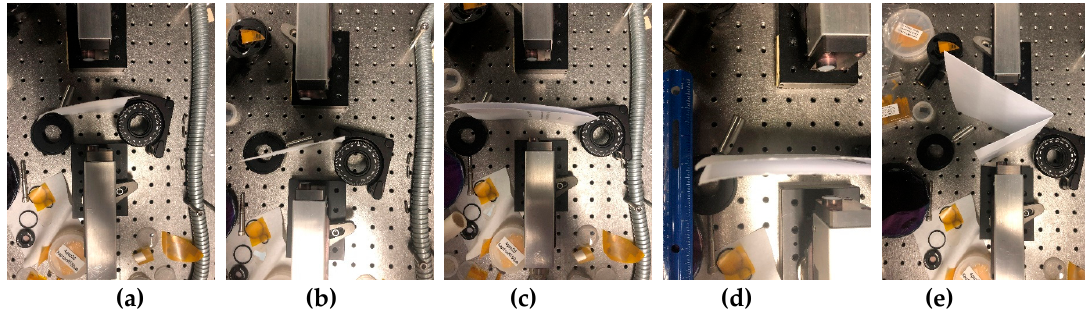
Figure 17 . Location of the paper sheets in the THz spectrometer (a – e). One (a,b) , two (c,d) and four sheets (e) placed at different distances and angles with respect to the receiver. sheets ( e ) placed at di ff erent distances and angles with respect to the receiver.